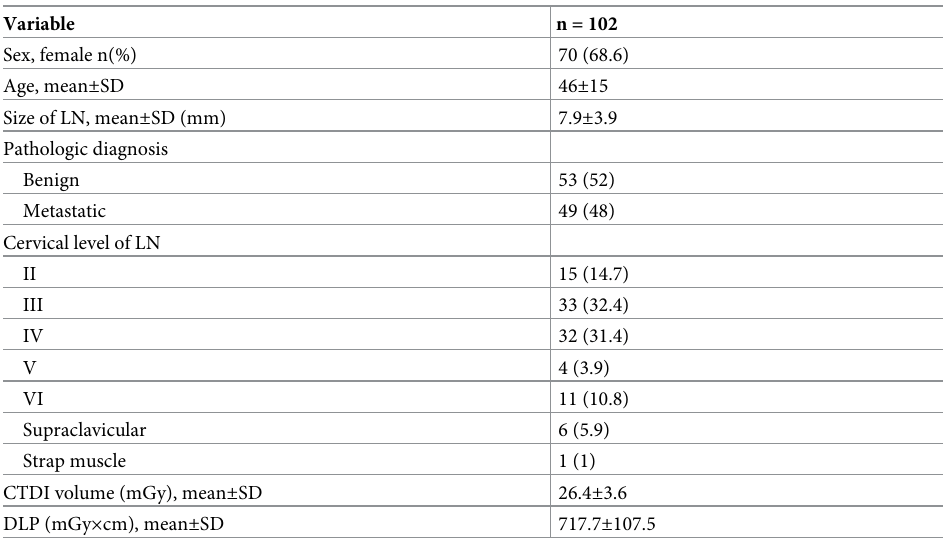
Table 1. Baseline characteristics of study